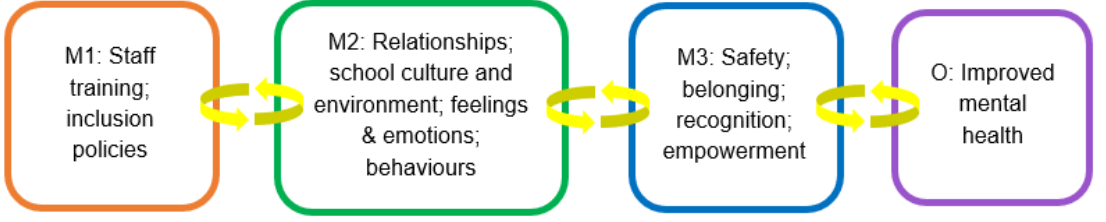
Figure 4. Interventions that change institutional school culture.